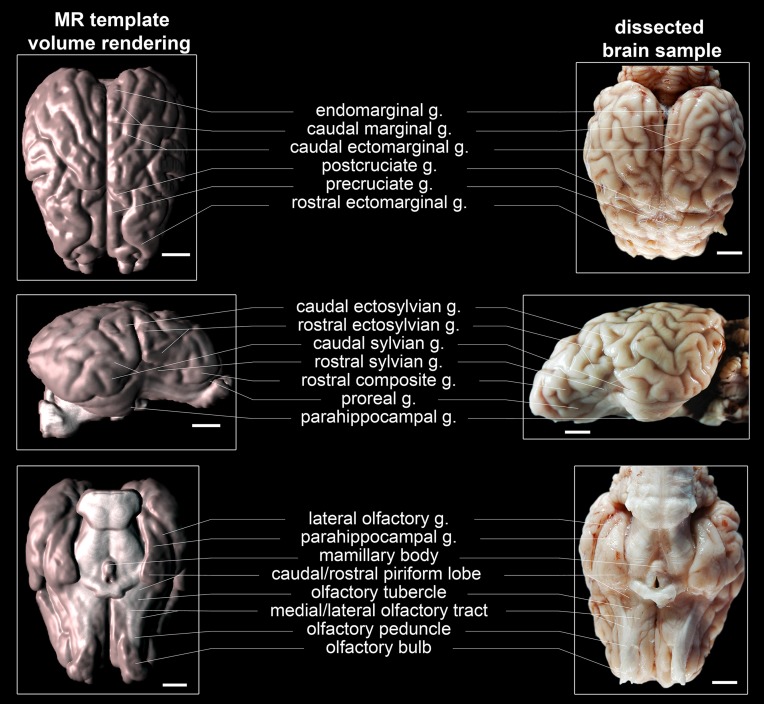
Topography of volume rendered, population-averaged ovine template, and a fixed specimen. The most relevant gyri and tractus were labeled in accordance with current neuroanatomical literature (Schmidt et al., 2012) and the Nomina Anatomica Veterinaria [NAV; International Committee on Veterinary Gross Anatomical Nomenclature (ICVGAN), 2012] except the endomarginal gyrus, which is not differentiated from the marginal gyrus according to the NAV. Scale bars: 10 mm.